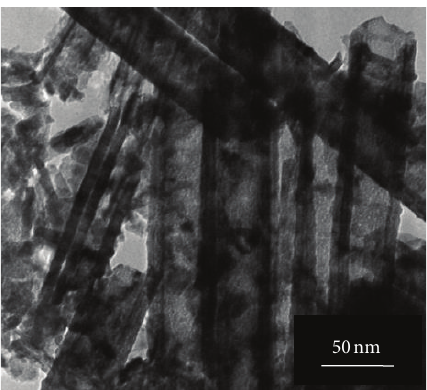
Figure 2: TEM image of anodic WO 3 nanostructures obtained in